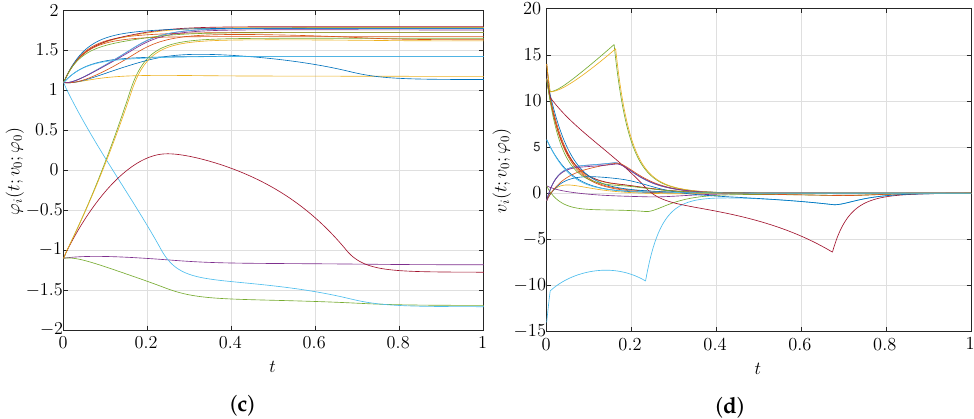
Figure 6. Numerical simulation with MATLAB of a memristor CNN for horizontal line detection. ( a ) Time evolution of fluxes ψ i ( ; ϕ 0 ,0 ) for the 13th row of the CNN; ( b ) evolution of nonlinear · ( resistor charges ; ϕ 0 ,0 ) ; ( c ) evolution of fluxes ϕ i ( ; v 0 , ϕ 0 ) ; ( d ) evolution of capacitor voltages Q R, i · · v i ( ; v 0 , ϕ 0 ) ·